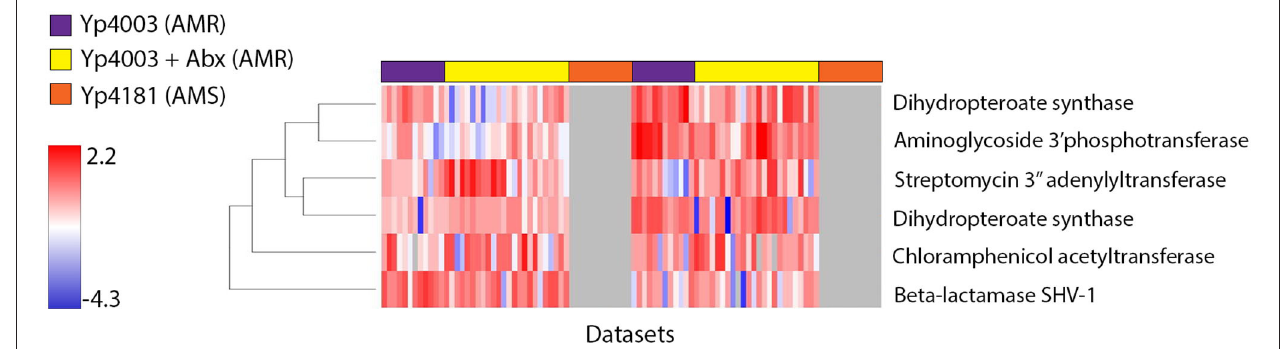
FIGURE 5 | Expression of AMR-conferring proteins encoded by the Y. pestis MDR plasmid pIP1202 occurs both in the presence and absence of streptomycin and at both early and late time points. Proteins are represented in individual rows along the y-axis, and datasets are represented as individual columns along the x-axis. Datasets from Y. pestis AMR strain Yp4003 grown without streptomycin are highlighted across the top of the image in purple, datasets of Yp4003 grown with streptomycin are highlighted in yellow, and datasets of Y. pestis AMS strain Yp4181, which does not contain the MDR plasmid, are highlighted in orange. Hierarchical clustering was used to group proteins with similar expression trends. Expression levels are shown on a scale from blue (low) to red (high). Gray indicates the protein was not observed in a dataset.